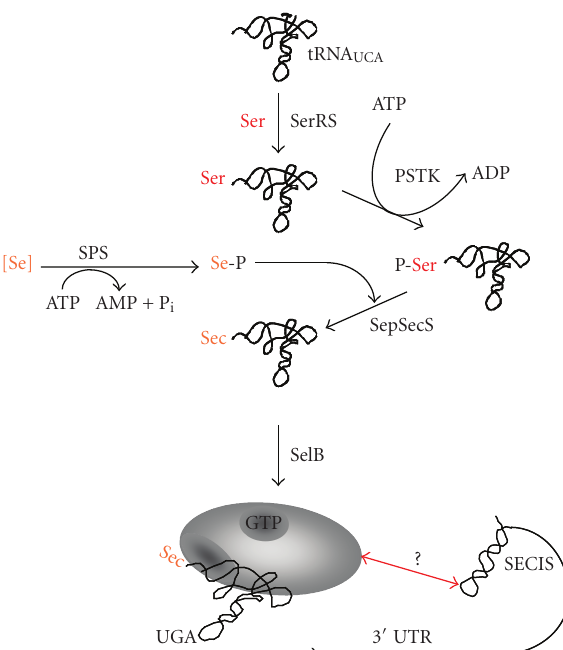
Figure 3: Schematic representation of selenocysteine biosyn- thesis and incorporation in Archaea. 3 (cid:3) UTR, 3 (cid:3) -untranslated region; PSTK, seryl-tRNA sec kinase, [Se], reduced Se-species; SelB, Sec-specific elongation factor; SepSecS, O -phosphoseryl-tRNA sec : selenocysteine synthase; Ser, serine; Se-P, seleno(mono)phosphate; SerRS, seryl-tRNA synthetase; SPS, selenophosphate synthetase; see text for